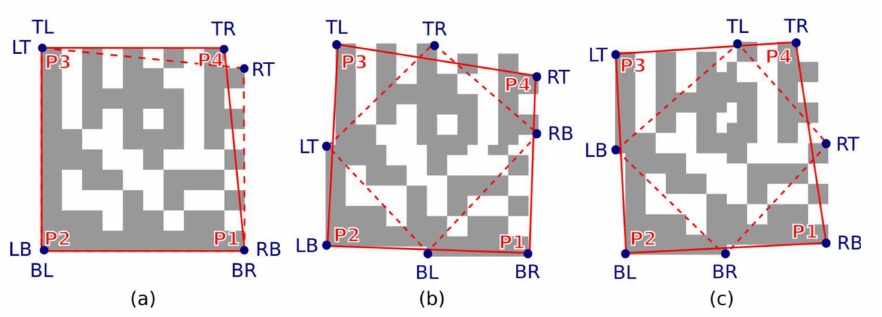
Figure 10. Outer bounding boxes of candidate regions. ( a ) unrotated code; ( b ) rotated clockwise; ( c ) rotated